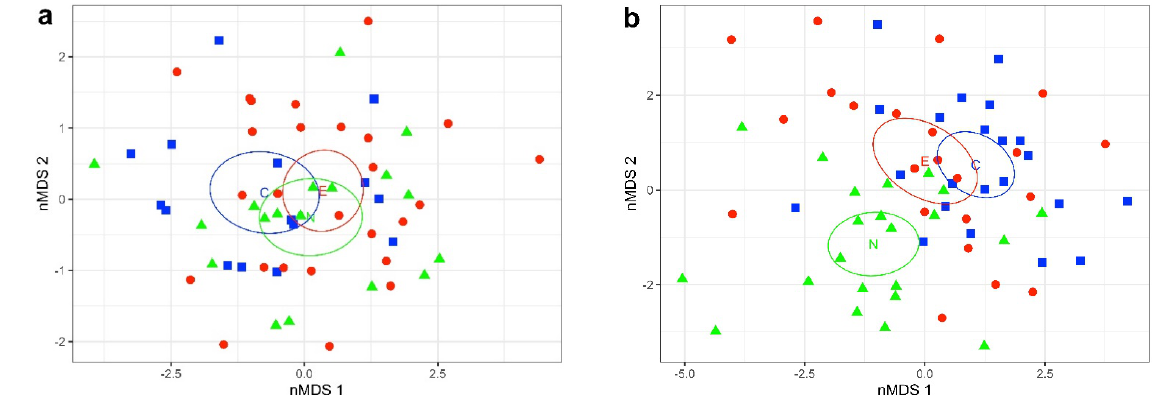
Figure 2. Sepia typica nMDS plots of meristic counts by area for ( a ) females and ( b ) males. Symbols denote sampling area: Northwest ( green triangles ); Central ( blue squares ); Eastern ( red dots ). Alpha characters denote the centre of distribution per area (C = Central, E = Eastern, and N = Northwest Areas) and the ellipses indicate the 95% confidence interval about the centroids.